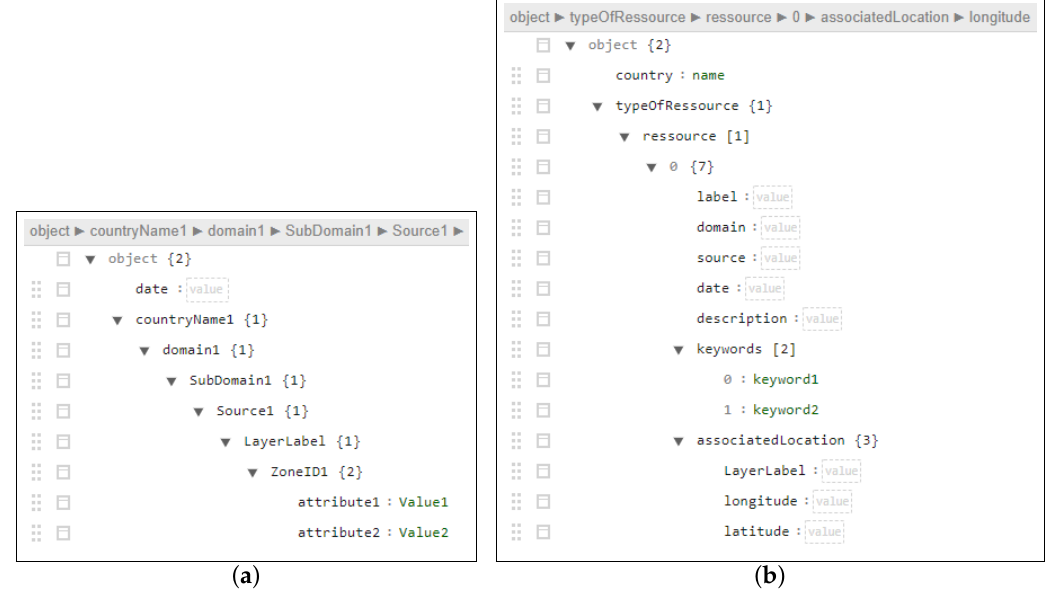
Figure 3. Structure of ( a ) spatiotemporal and ( b ) resource-related